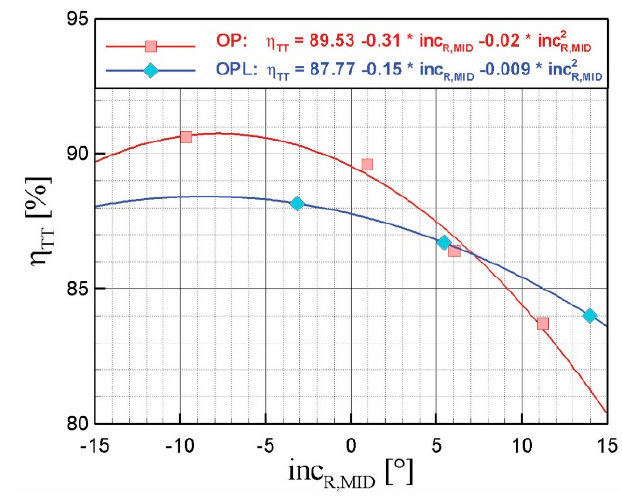
Figure 18. Total to total efficiency versus rotor incidence angle at midspan, for the two sets of tests, OP and OPL.